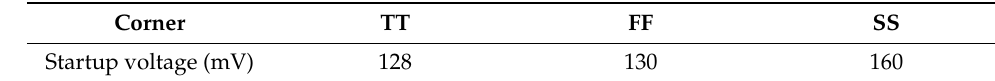
Table 2 lists the tracking efficiency under the extreme temperatures and process